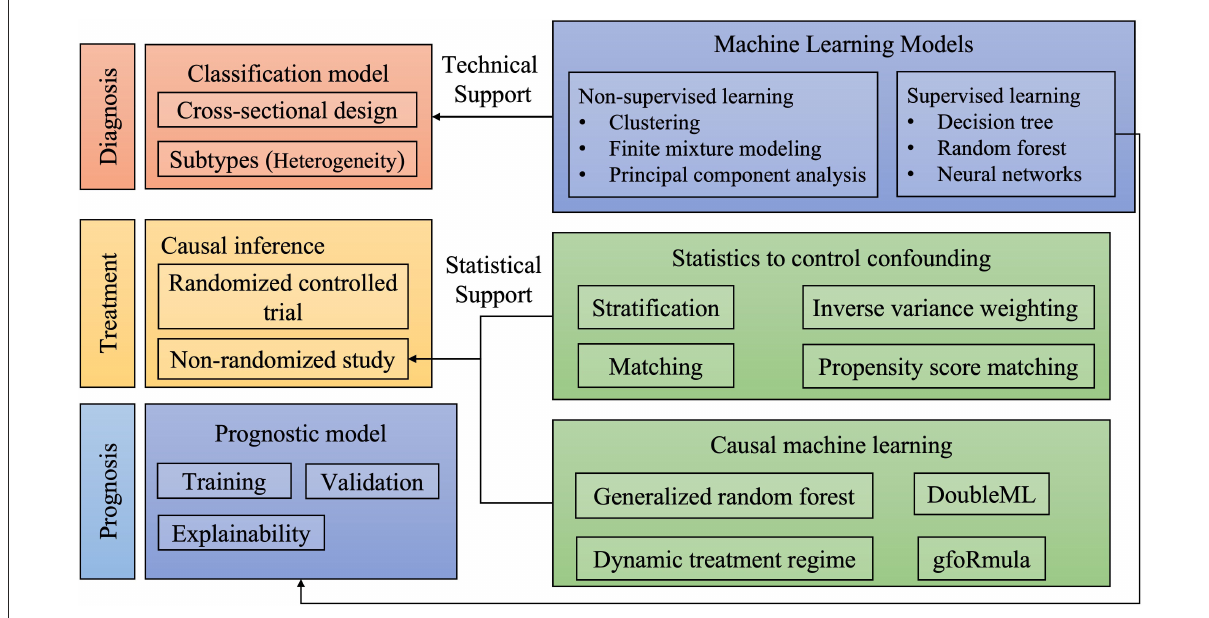
FIGURE1 Illustrations of the application of artificial intelligence to various aspects of clinical